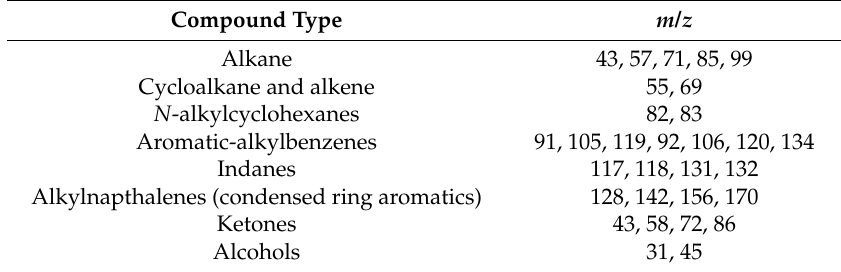
Table 1. Compound type with associated ions commonly observed in the electron ionization spectra from the components in ignitable liquids and substrate pyrolysis